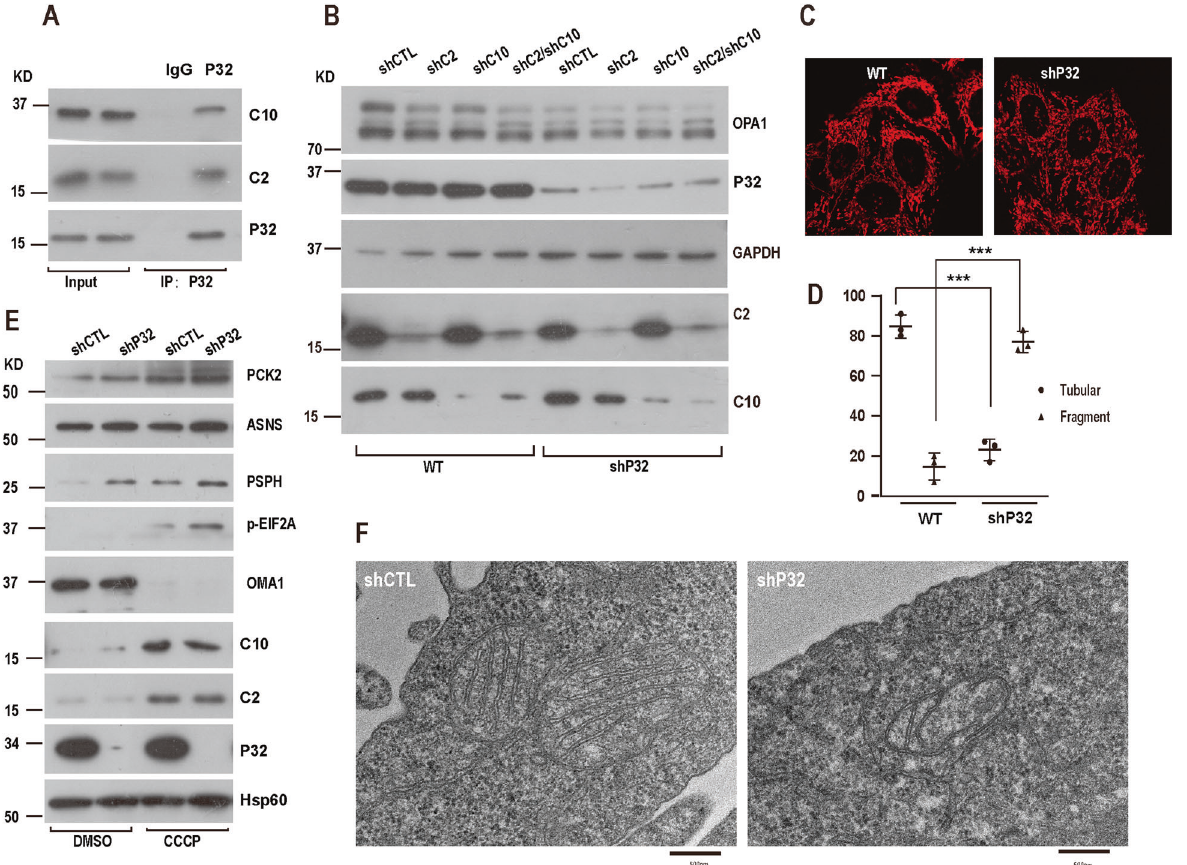
Fig. 5 P32 interacts with CHCHD2 and CHCHD10 to regulate mitochondrial morphology and mtISR. A Hela cell lysates were immunoprecipitated with anti-P32 antibody or IgG, followed by immunoblotting using the indicated antibodies. B Lysates of P32-knockdown- Hela cells treated with DMSO or CCCP (10 uM, 124 h) analyzed for indicated protein expression by immunoblot. C Representative immuno fl uorescence images of mitochondrial morphology in control, shP32 Hela cells (mean ± s.d. of n = 3 independent biological samples; two-way ANOVA with Tukey ’ s multiple comparisons correction, *** P < 0.001). D Mitochondrial morphology described in C was counted according to the criteria detailed in Experimental Procedures. E Representative western blots of the indicated proteins in WT and shP32 Hela cells after 10uM CCCP treatment for 24 h. F Representative electron microscopic images and quanti fi cation of mitochondrial ultrastructure in WT or shP32 Hela